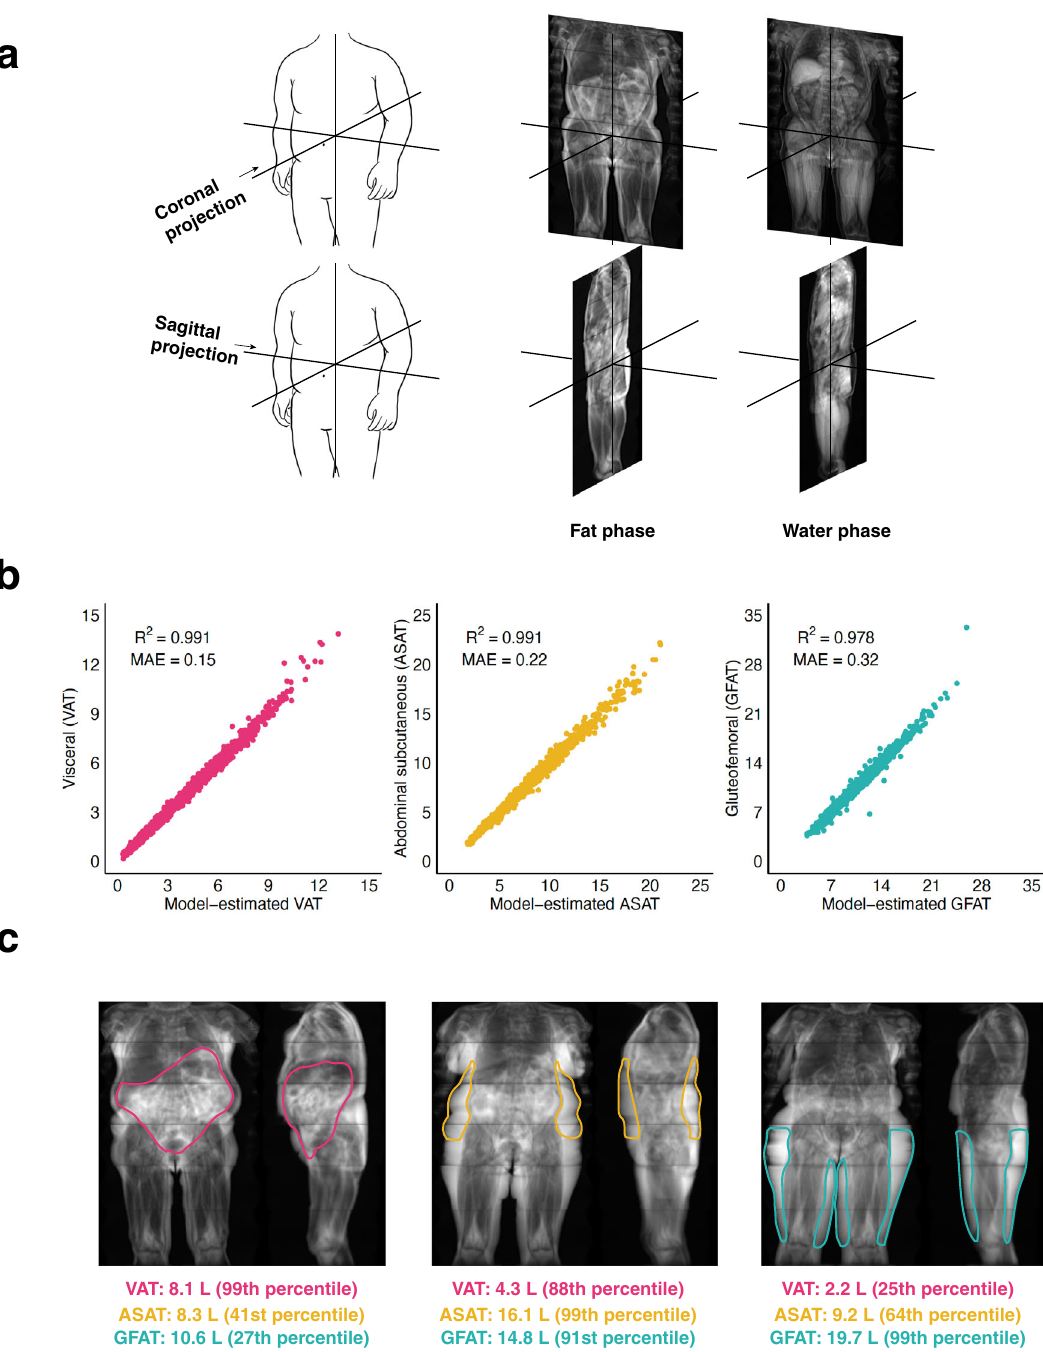
Fig. 1 | Convolutional neural networks to quantify adipose tissue depots from body MRI images. a Two-dimensional projections are created by computing the mean pixel intensity along the coronal and sagittal axes. Two images for each participant were used as inputs into the convolutional neural network: one con- sistingofthecoronalandsagittaltwo-dimensionalprojectionsinthefatphase,and another consisting of the same projections in the water phase. b Convolutional neuralnetworkstrainedontwo-dimensionalMRIprojectionsachievednear-perfect prediction of each fat depot volume in the holdout set (Supplementary Table 3).